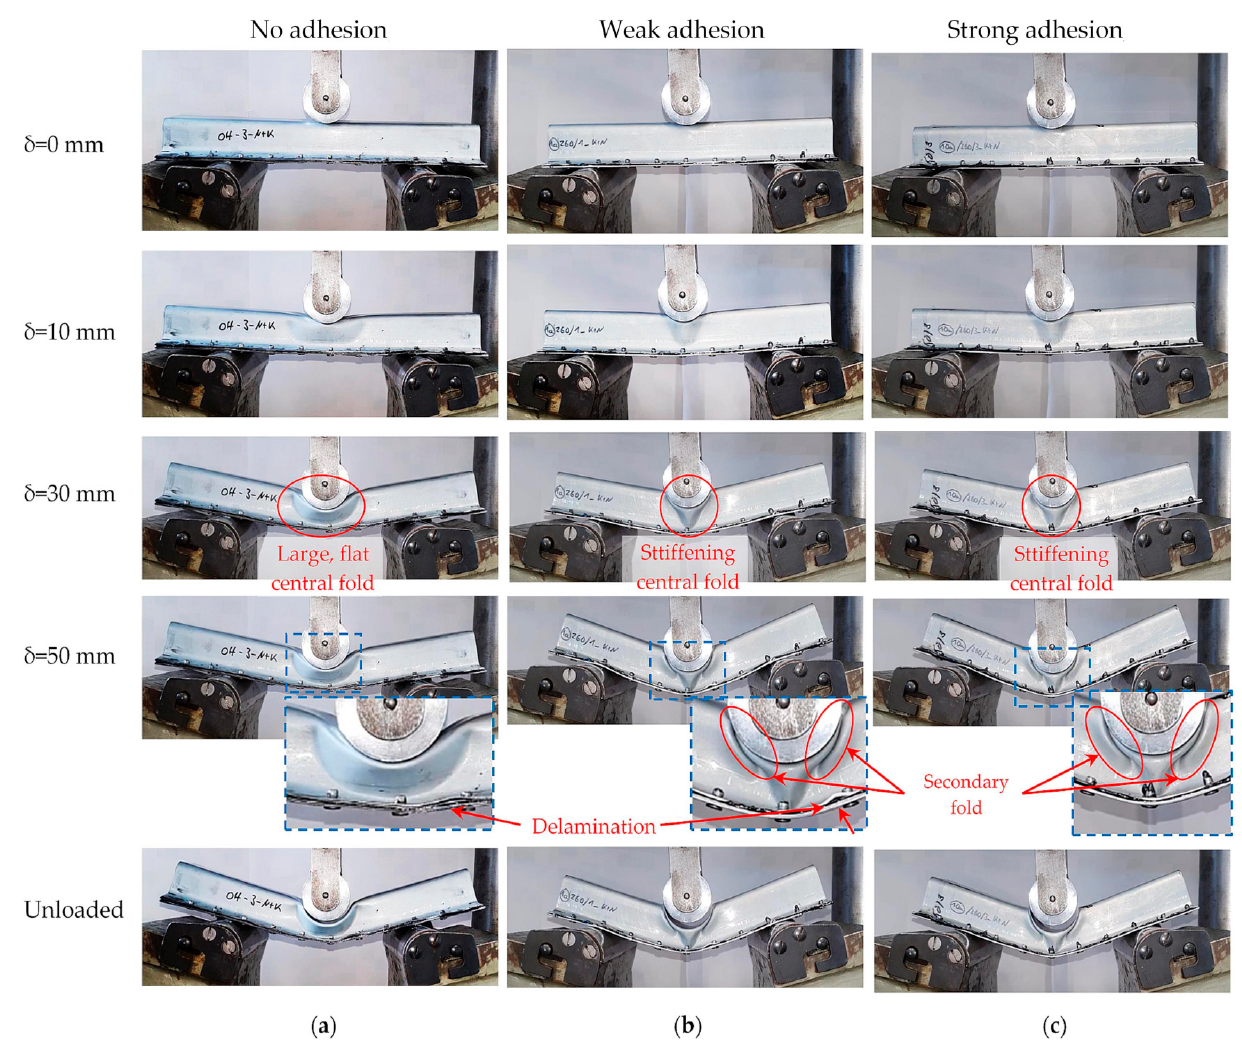
Figure A3. Photographic presentation of quasi-static bending behavior at different time steps for the top-hat crashboxes ( a ) without, ( b ) with weak, and ( c ) with strong adhesion strength.